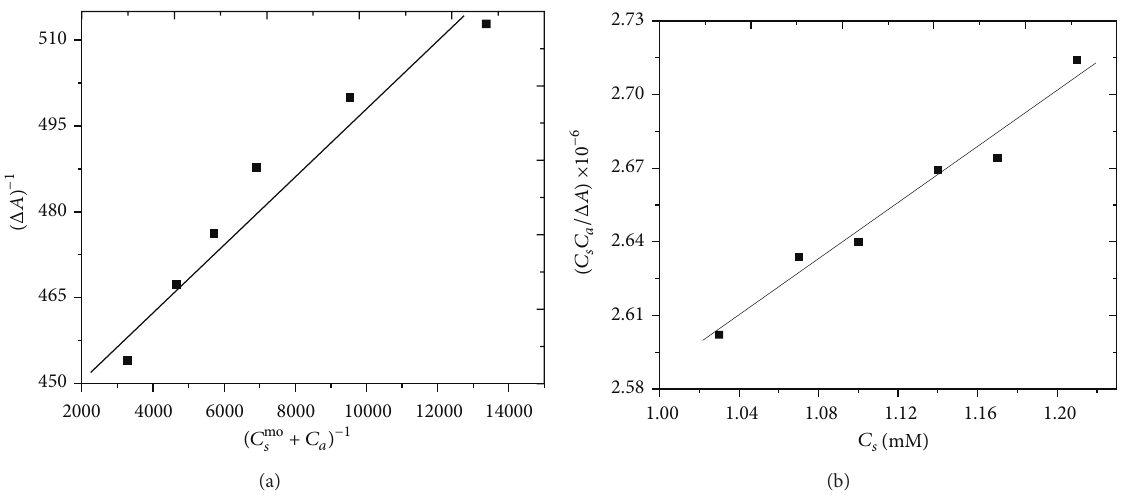
Figure 4: (a) Relationship between (Δ𝐴) −1 and (𝐶 𝑠 + 𝐶 𝑚𝑜 𝑠 ) −1 for the calculation of partition coefficient (𝐾 𝑥 ) for RO122/CTAB system. (b) Plot for calculation of binding constant (𝐾 𝑏 ) for RO122/CTAB system.